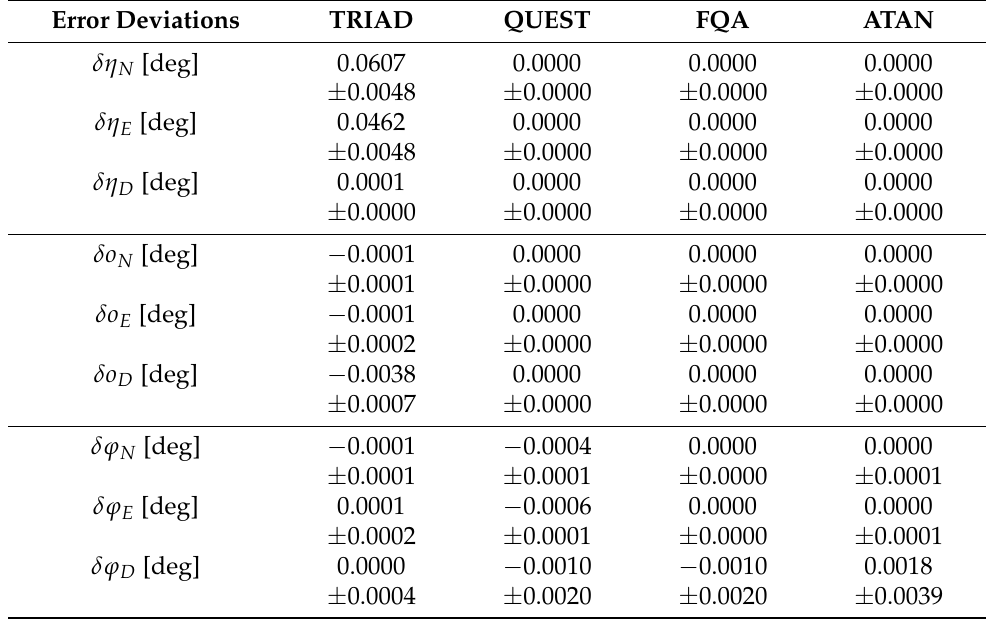
Table 4. Mean values and standard uncertainties of DCM normality, orthogonality, and alignment error deviations (estimated minus predicted values) in Monte Carlo simulated test.